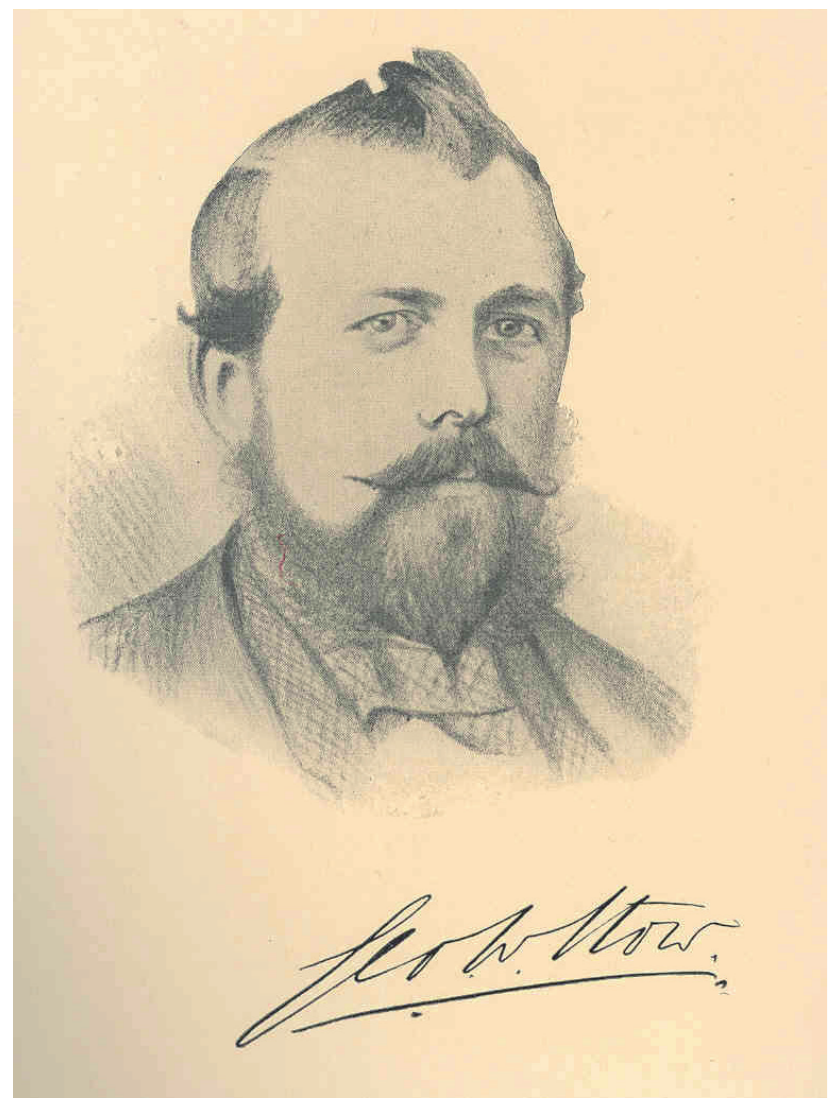
Illustration 1: GW Stow. Source: